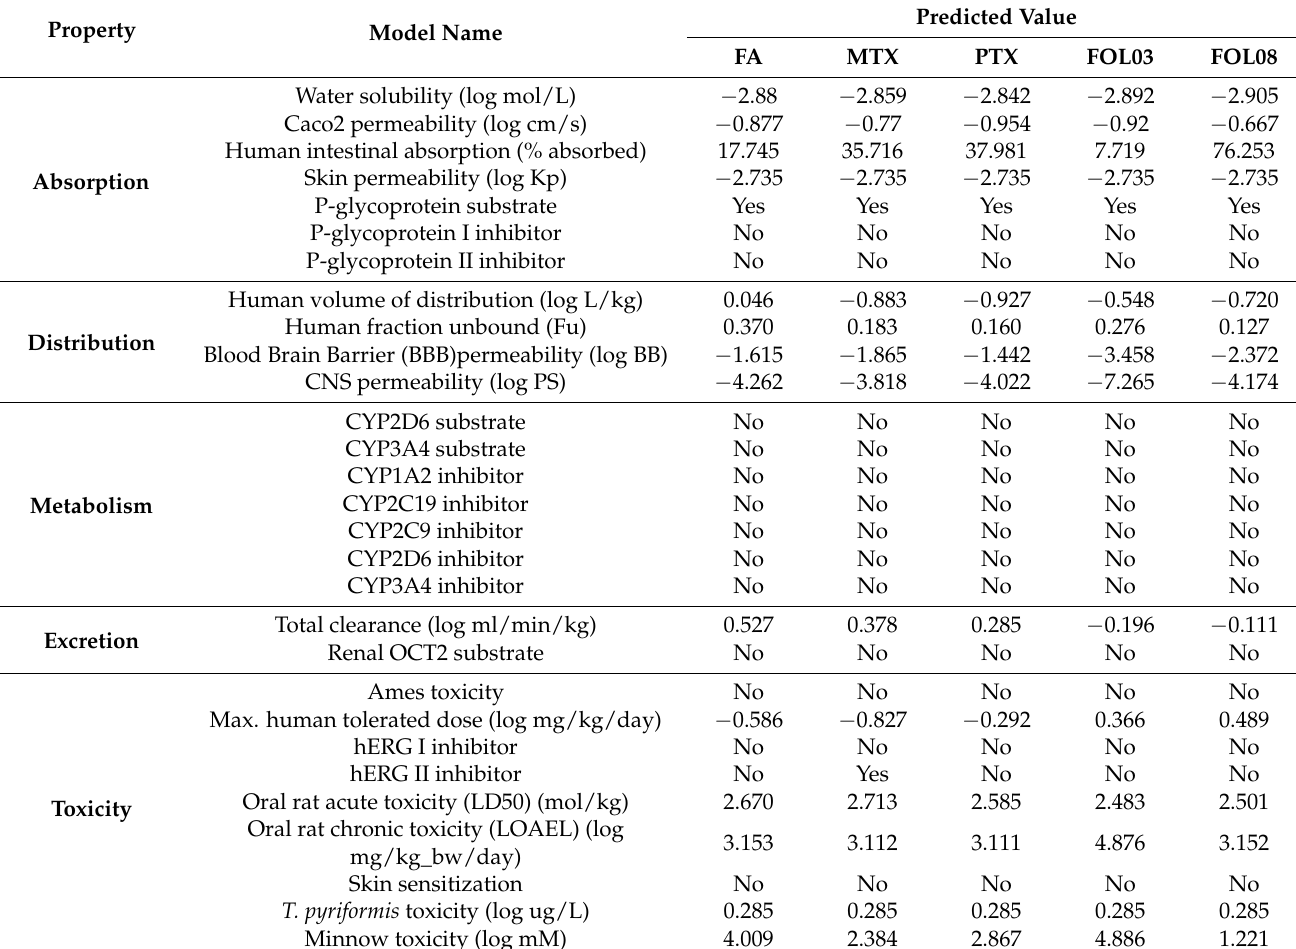
Table 4. Predicted ADMET properties of the ligands (FA, MTX, PTX, FOL03, and FOL08) using pkCSM and PreADMET.